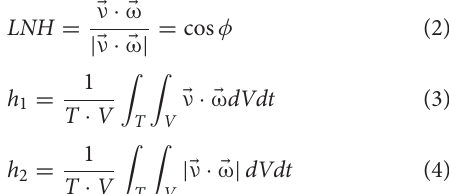
assumed the blood to be an incompressible,